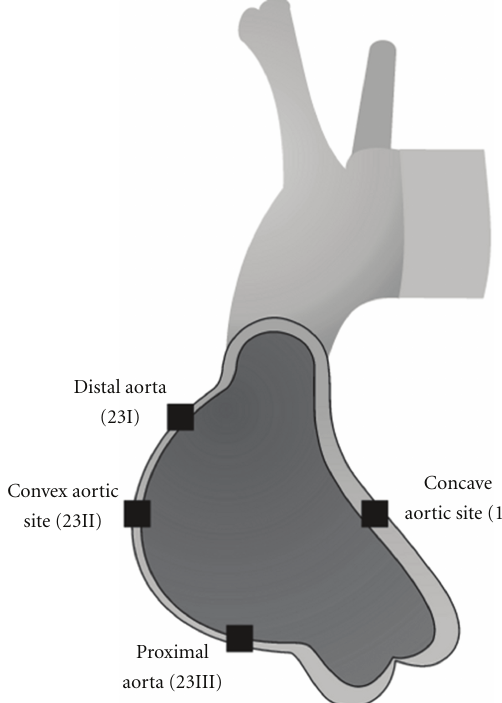
Figure 1: Schematic representation of ascending aneurysms. Re- sected tissue from the distal, convex, proximal, and concave aortic sites used for the analysis. Overall detection of MMPs and TIMPs at the concave and convex aortic